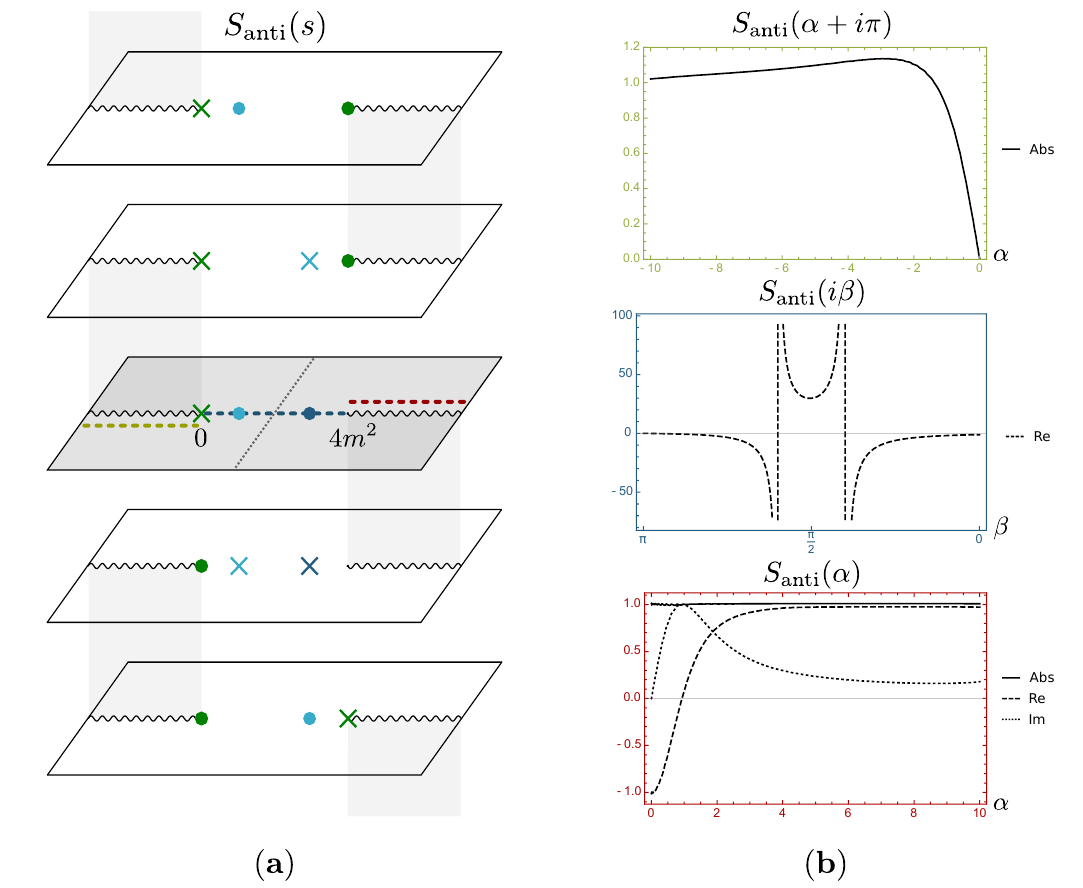
(in dark blue) GN